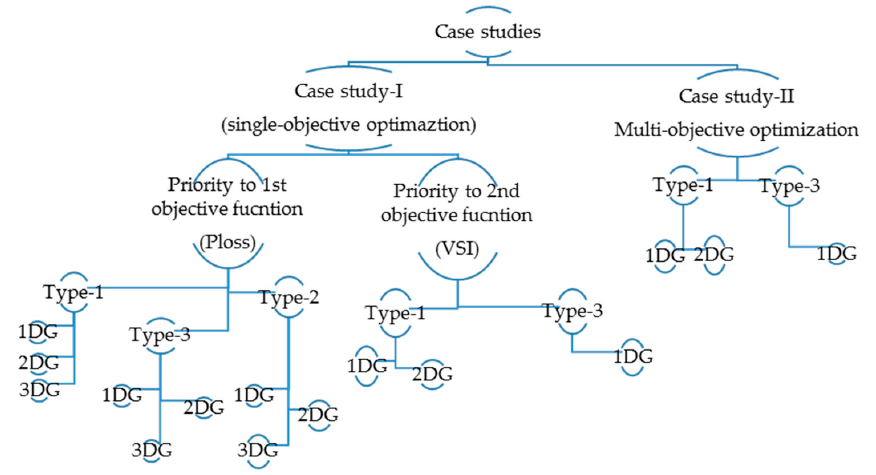
Figure 5. The conceptual framework of case studies.